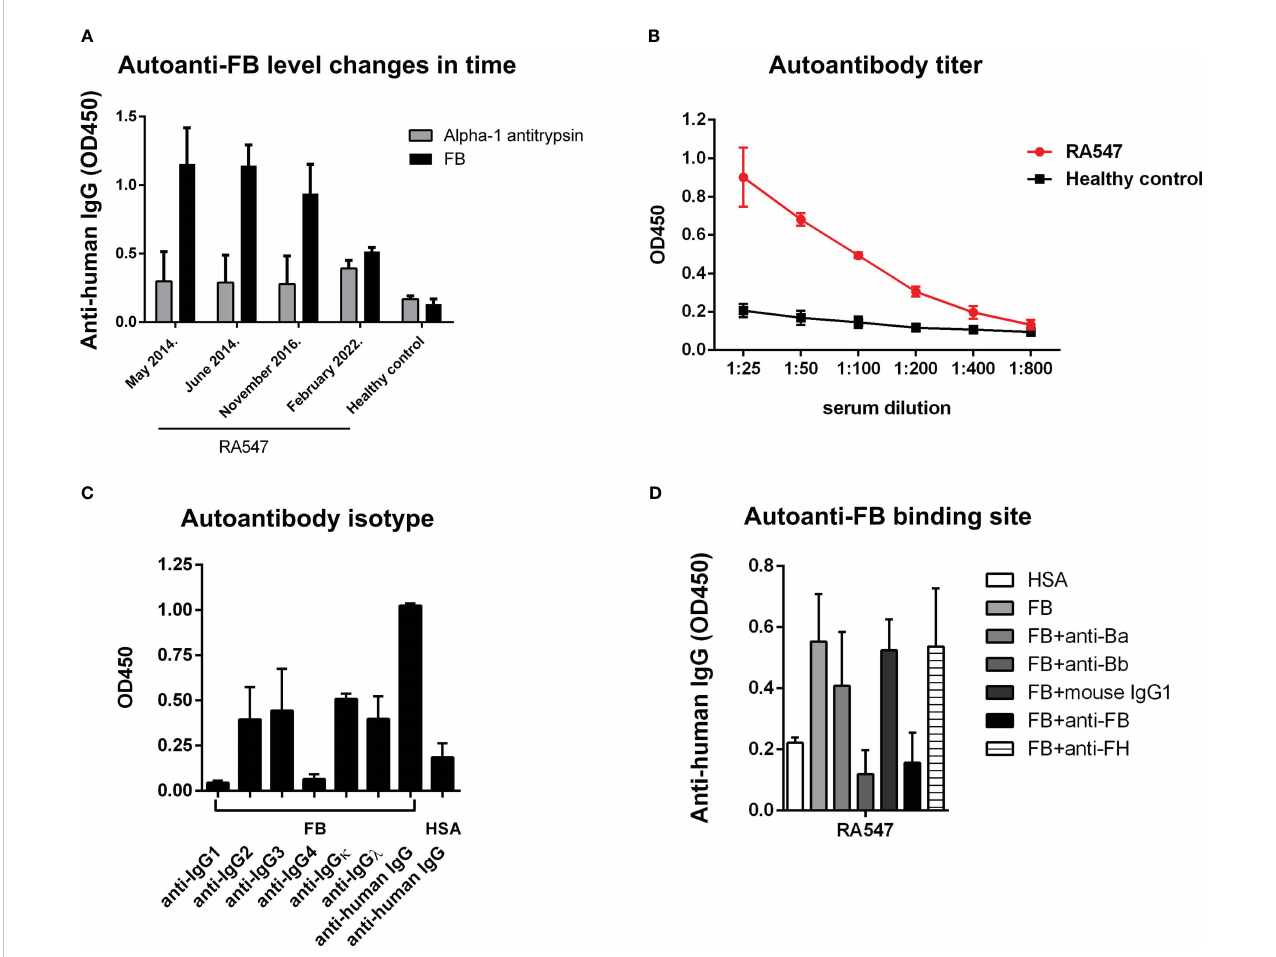
FIGURE 4 Autoantibody characterization. (A) We had serum samples from four time points to analyze the presence of autoanti-FB in RA547. Data are results ± SD of two experiments. (B) Titer of autoanti-FB was determined in ELISA, with serial dilutions of the patient ’ s serum. (C) Autoantibodies were added to immobilized FB, and the isotypes were determined with monoclonal antibodies against the IgG subclasses. Data are mean ± SD from two independent experiments. Values obtained with an autoantibody negative healthy control as a background were subtracted from the values obtained with RA547 before plotting. (D) Autoantibody binding to immobilized FB was decreased by the preincubation of FB with monoclonal anti-Bb antibody and with polyclonal anti-FB antiserum. Data are mean ± SEM from three independent experiments. Values obtained with an autoantibody negative healthy control as a background were subtracted from the values obtained with RA547.